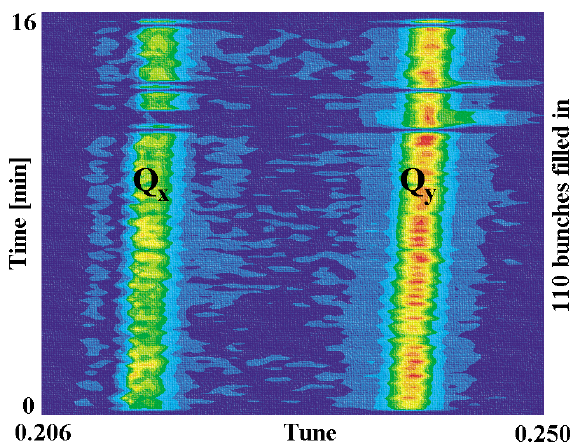
FIG. 1. (Color) Coherent tunes measured along a train of 110 proton bunches with 105 ns spacing in the Yellow ring. Because of coupling both transverse tunes are